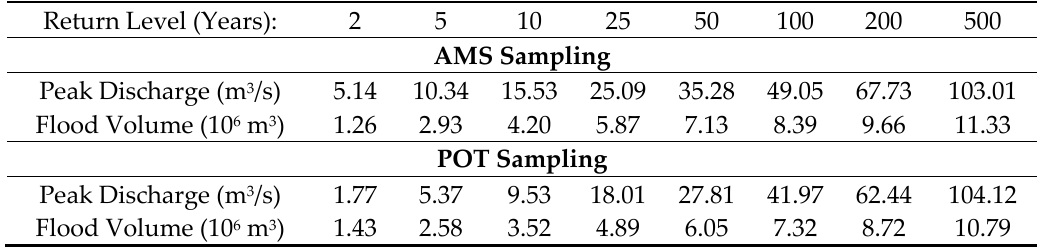
Table 1. Results of the Univariate Return Periods 2, 5, 10, 25, 50, 100, 200 and 500 for Peak Discharge and Flood Volume for Annual Maximum Series (AMS) and Peaks Over Threshold (POT), Yermasoyia